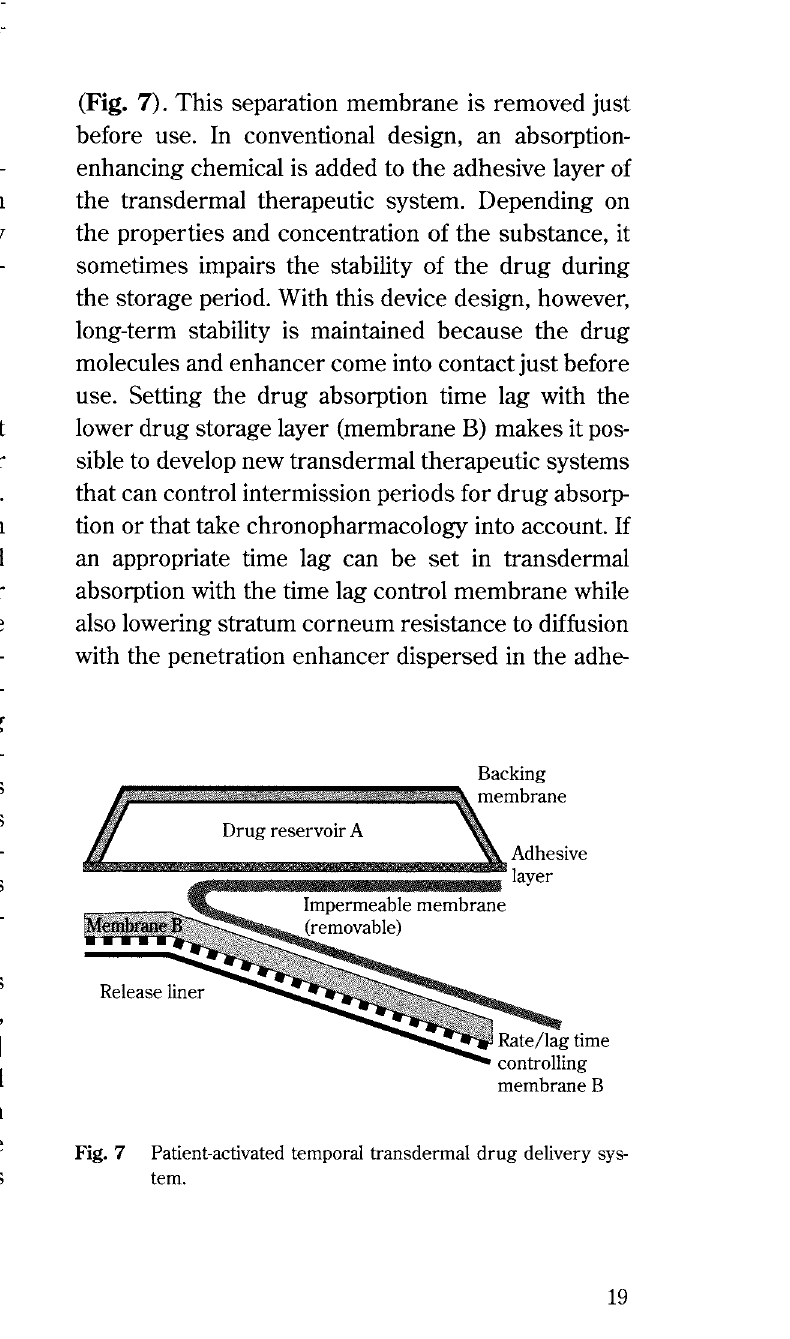
Fig. 6 The ultimate controlled release system. Bombardier beetle (courtesy of Mr. S. Kuribayashi).